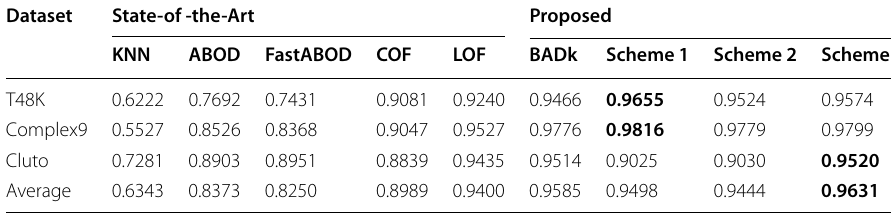
Bold values indicate are best-achieved